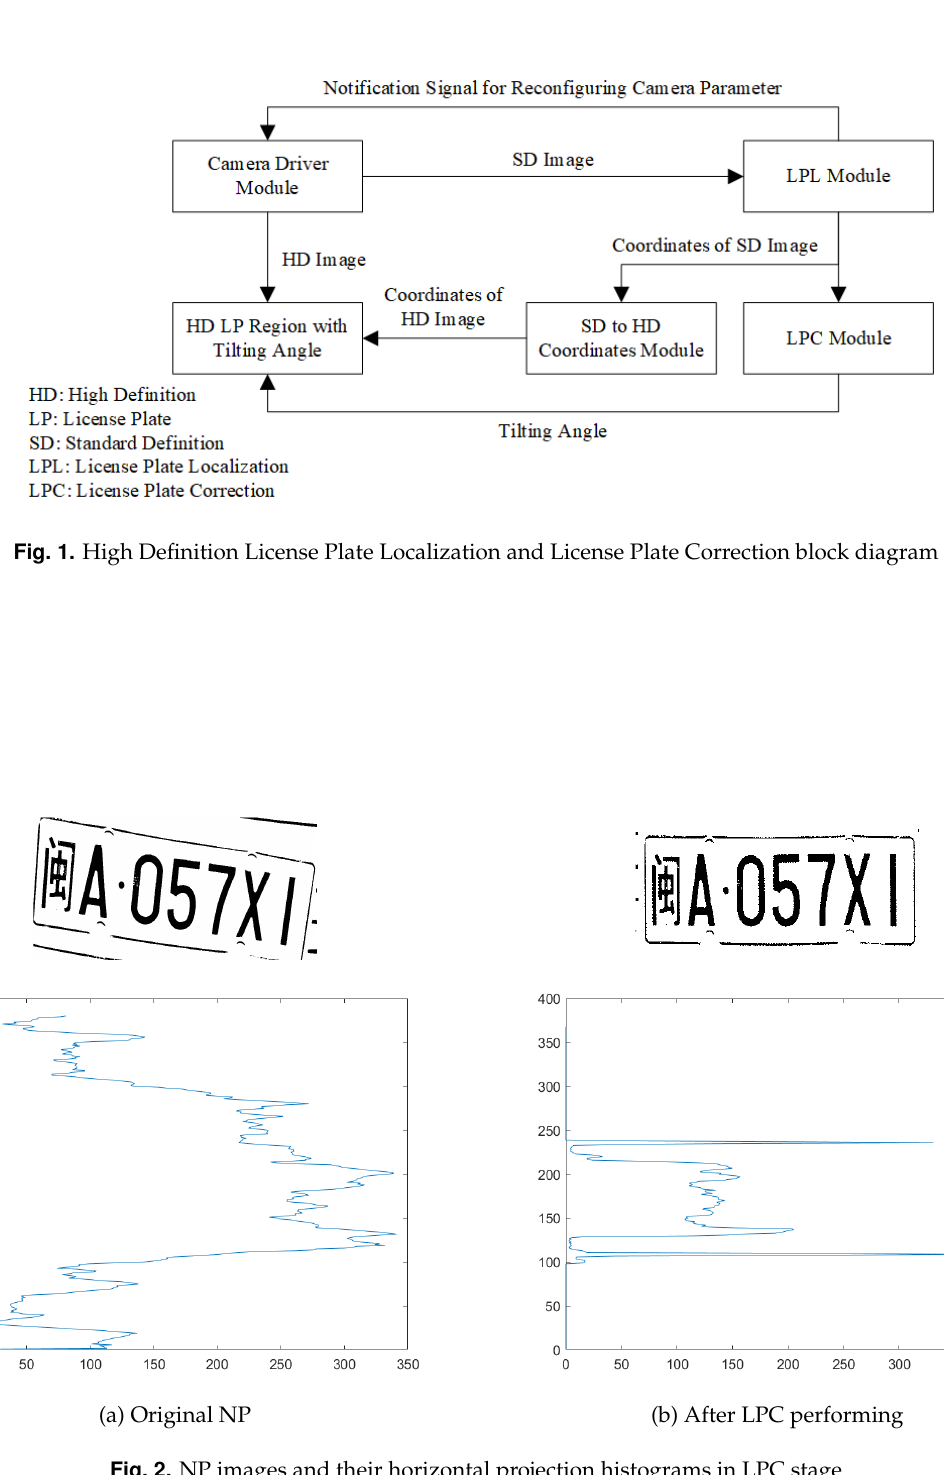
Fig. 2. NP images and their horizontal projection histograms in LPC